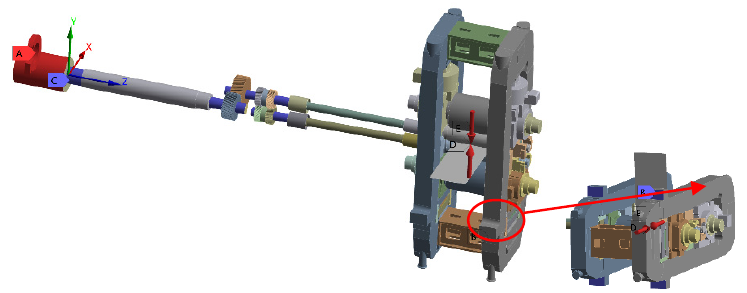
Figure 7. Finite element structure model: A—uniform torque; B—fixed constraints; C—cylindrical constraints; D—rolling force; E—rolling force.